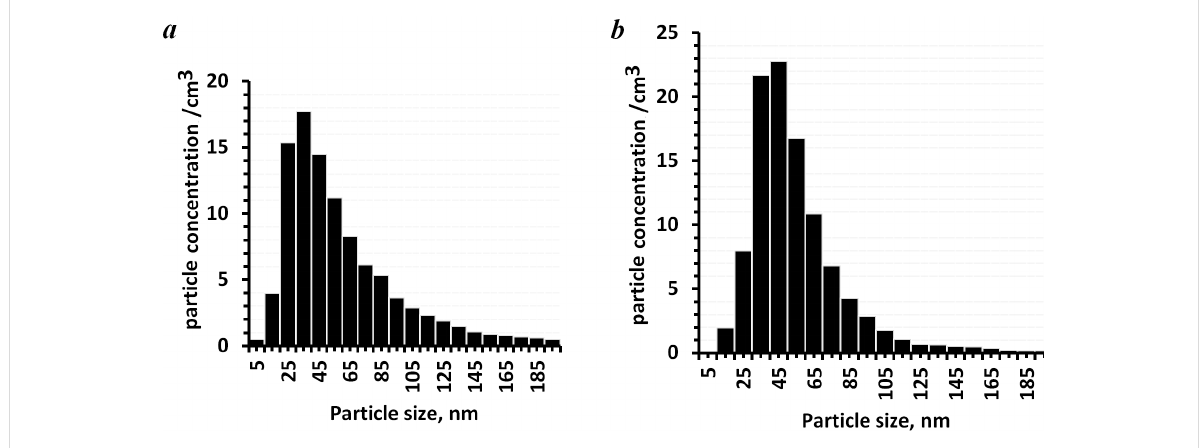
Figure 11: Histograms of the particle size distribution for NaNO 3 powders synthesized with the addition of 3 wt % ( а ) and 15 (b) wt %